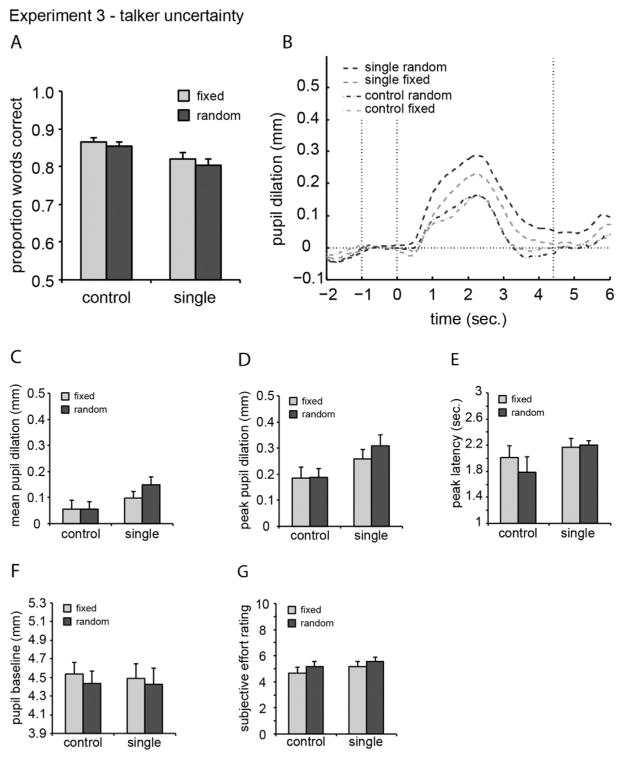
As Fig. 1, but for Experiment 3.